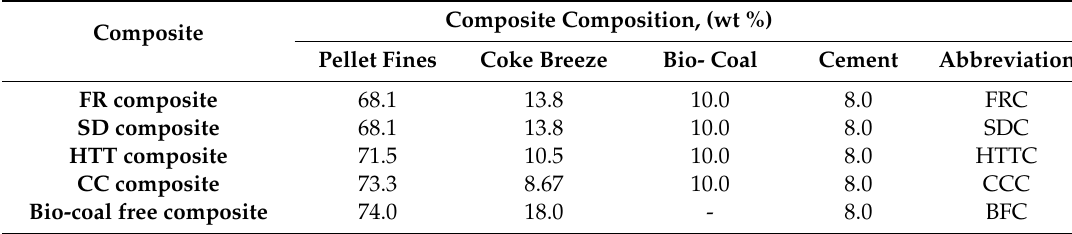
Table 5. Recipes of self-reducing composites.